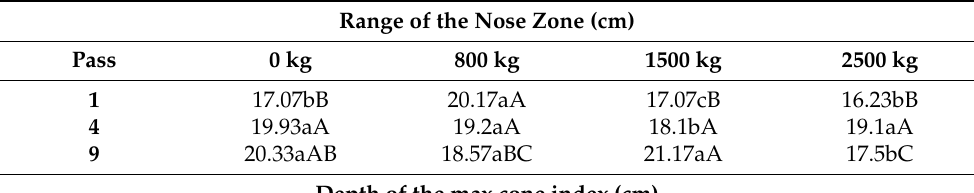
Table 2. Cone index analysis of the nose zone. Lowercase letters (abc) indicate the comparison under different pass conditions within the same traction group (vertical). Capital letters indicate the comparison under different traction conditions within the same pass condition